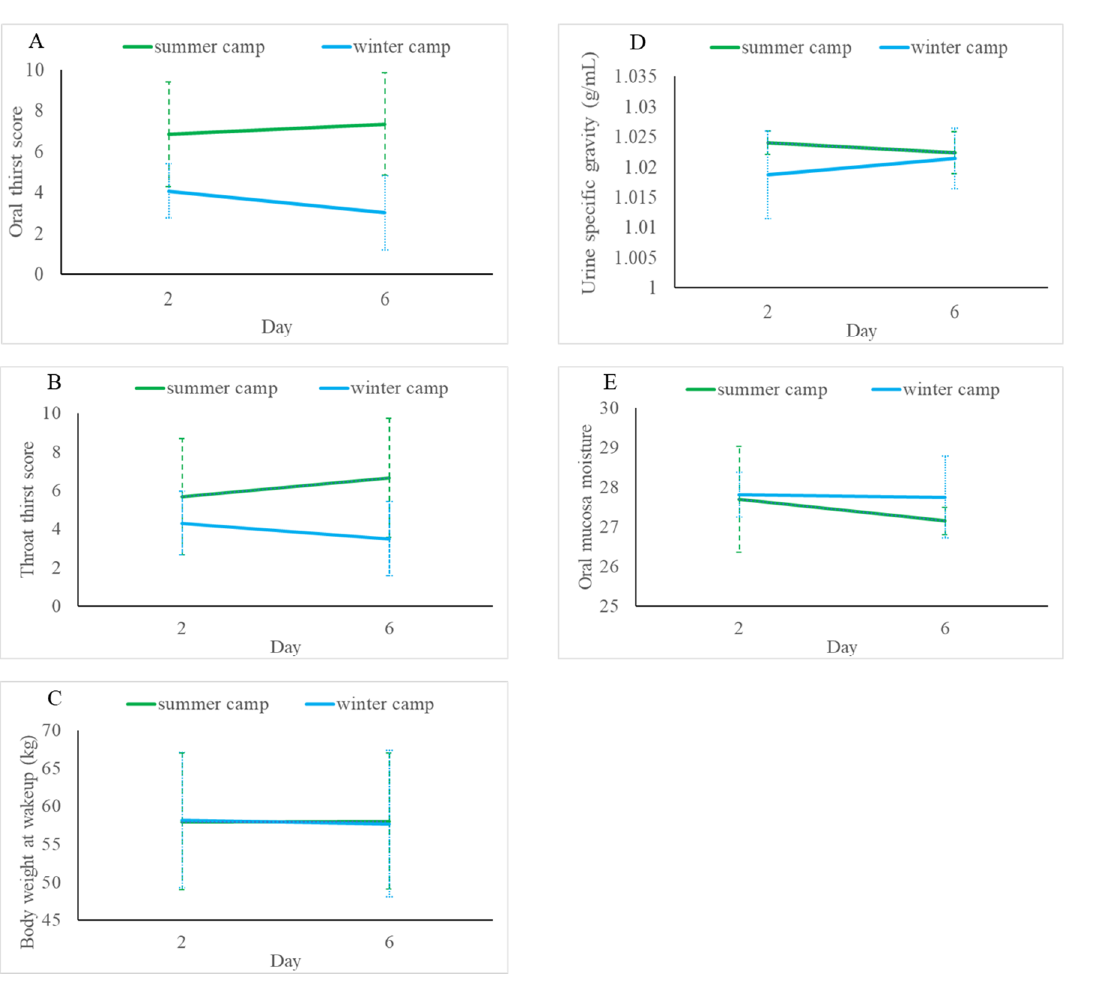
Figure 3. Transitions in oral thirst ( A ), throat thirst ( B ), body weight at wakeup ( C ), urine specific gravity ( D ), and oral mucosa moisture ( E ) during the summer and winter camps. Urine specific gravity above 1.020 g/mL indicates dehydration in sports. Oral moisture values range from 0 to 99.9, and values of ≥29.6, 28.0–29.5, and ≤27.9 are defined as normal, borderline dry mouth, and dry mouth, respectively. Error bars reflect standard deviation.